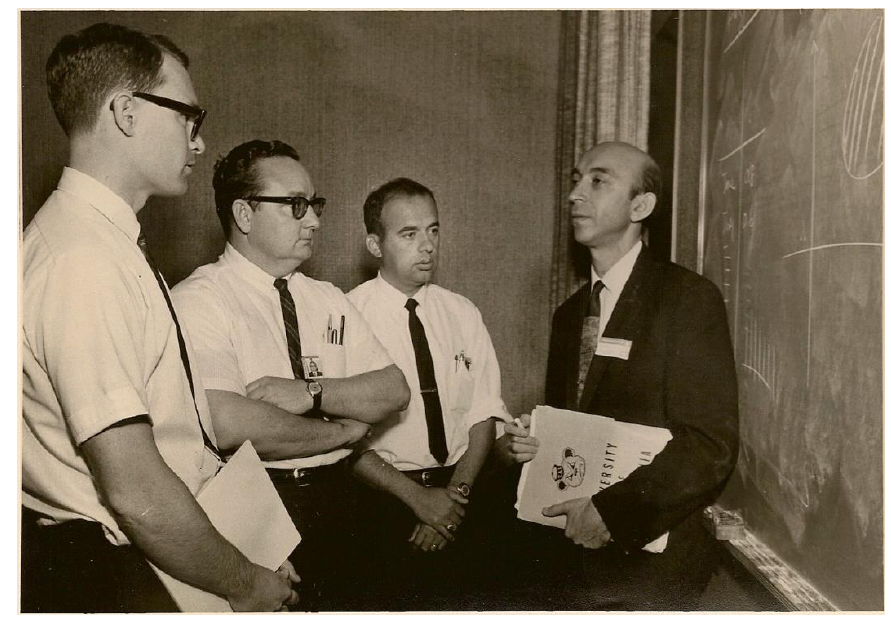
Figure 2. Lotfi A. Zadeh, undated photo, approximately 1950s, photo credit: Fuzzy archive Rudolf Seising.